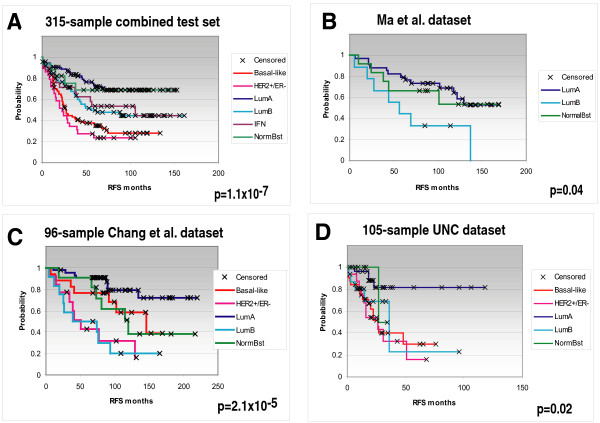
Kaplan-Meier survival curves of breast tumors classified by intrinsic subtype. Survival curves are shown for (A) the 315-sample combined test set classified by hierarchical clustering using the Intrinsic/UNC gene set and (B) the 60-sample Ma et al., (C) 96-sample Chang et al., and (D) 105-sample (used to derive the Intrinsic/UNC gene set) datasets classified by the Nearest-Centroid predictor (Single Sample Predictor).